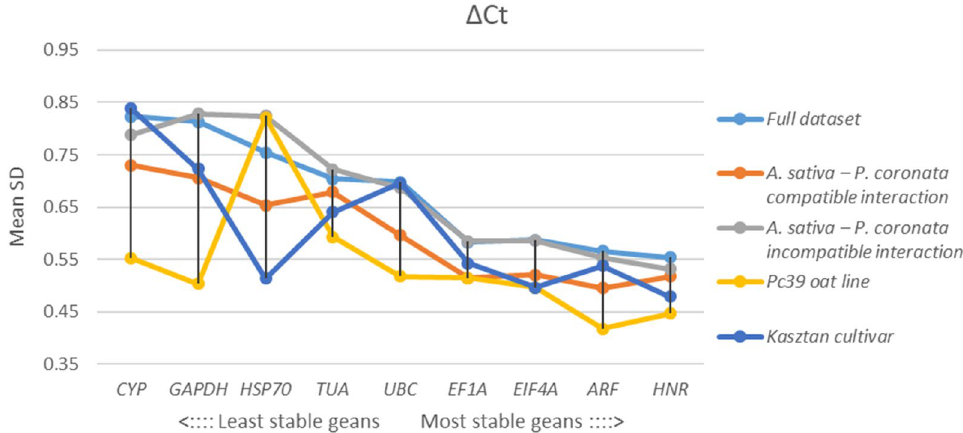
Figure 5. Mean standard deviation (mean SD) of tested RGs determined by ΔCt method for full dataset, compatible reaction dataset, incompatible reaction dataset, Pc39 oat line dataset and Kasztan cultivar dataset. Low average SD indicate high expression stability across samples set.